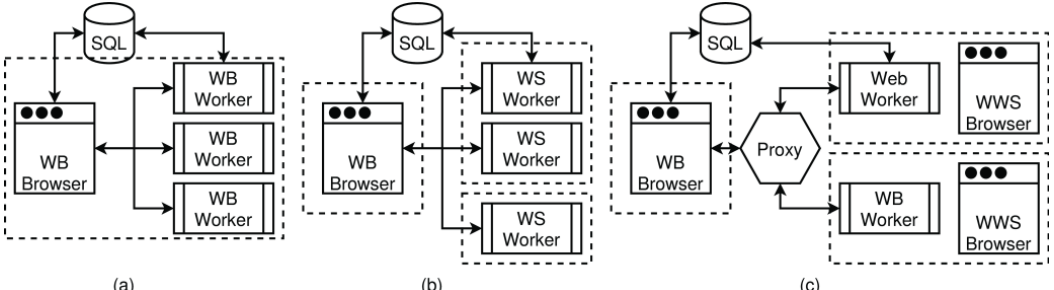
Figure 13. The distributed-parallel worker architectures used for multi-model ML training: ( a ) parallel web workers managed by a WorkBook; ( b ) distributed-parallel shell workers; ( c ) distributed web WorkShell workers; WB: WorkBook, WS: WorkShell, WWS: Web WorkShell.